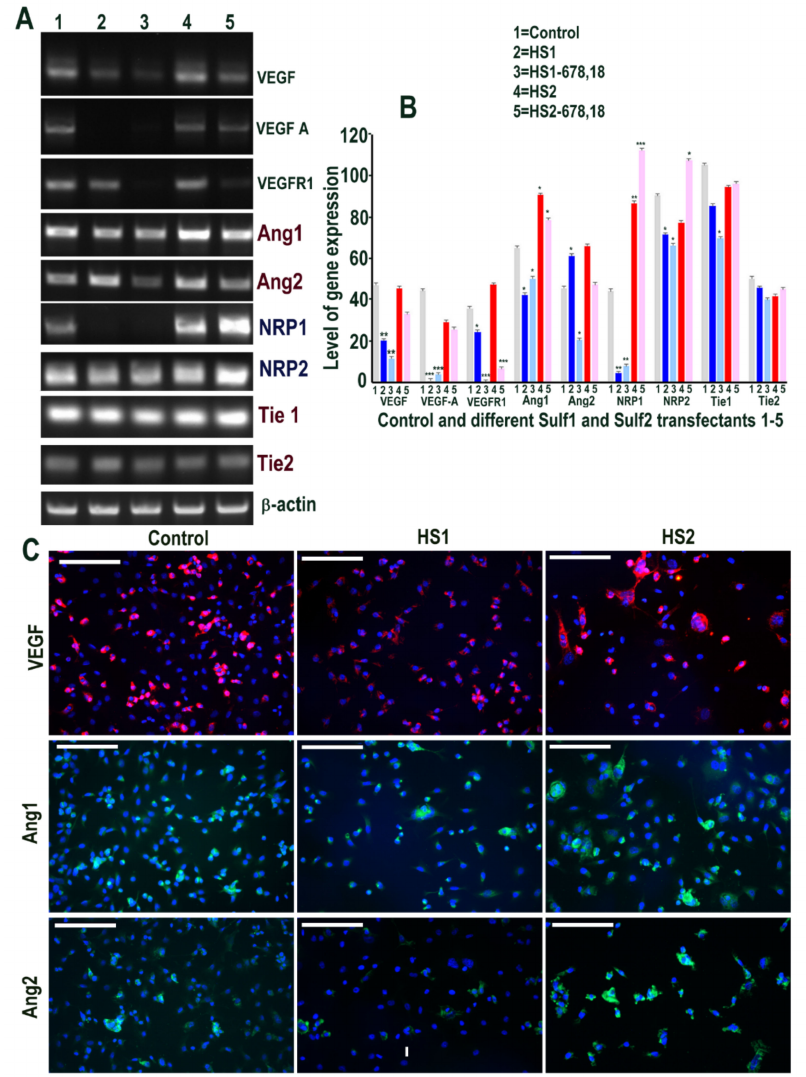
Figure 8. ( A , B ) Changes in levels of VEGF cell signalling including its receptors (Ang1, Ang2, NRP1, NRP2, Tie1 and Tie2) following transfections of ea926 cells with (1) pcDNA3, (2) full length Sulf1 (HS1), (3) shorter inactive Sulf1 (HS1-678,18), (4) full length Sulf2 (HS2) and shorter inactive Sulf2 (HS2- 678,18) examined by RT PCR analysis quantified using image J analysis. Error bars = means ± SD; *** p < 0.0001; ** p < 0.001; * p < 0.01. ( C ) Changes in VEGF cell signalling following transfections were also examined by immunostaining for VEGF, Ang1 and Ang2 using immunofluorescence procedure. Scale bar: 100 µ